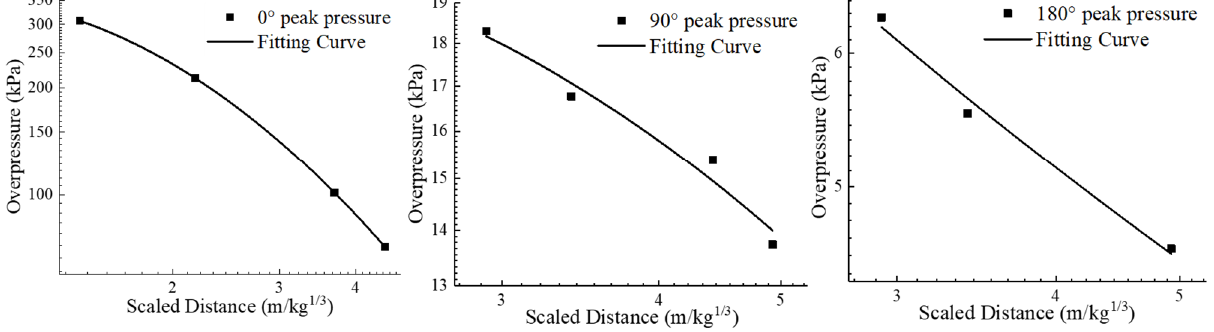
Figure 11. P – z fitting curves in different directions.